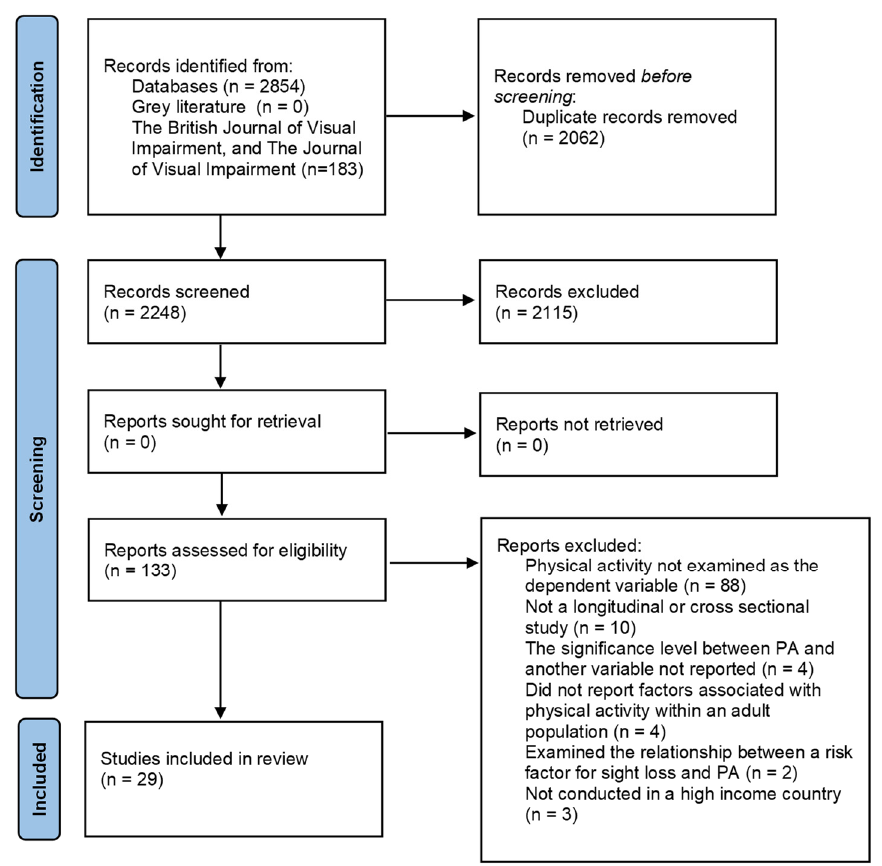
Figure 1. PRISMA flow diagram.